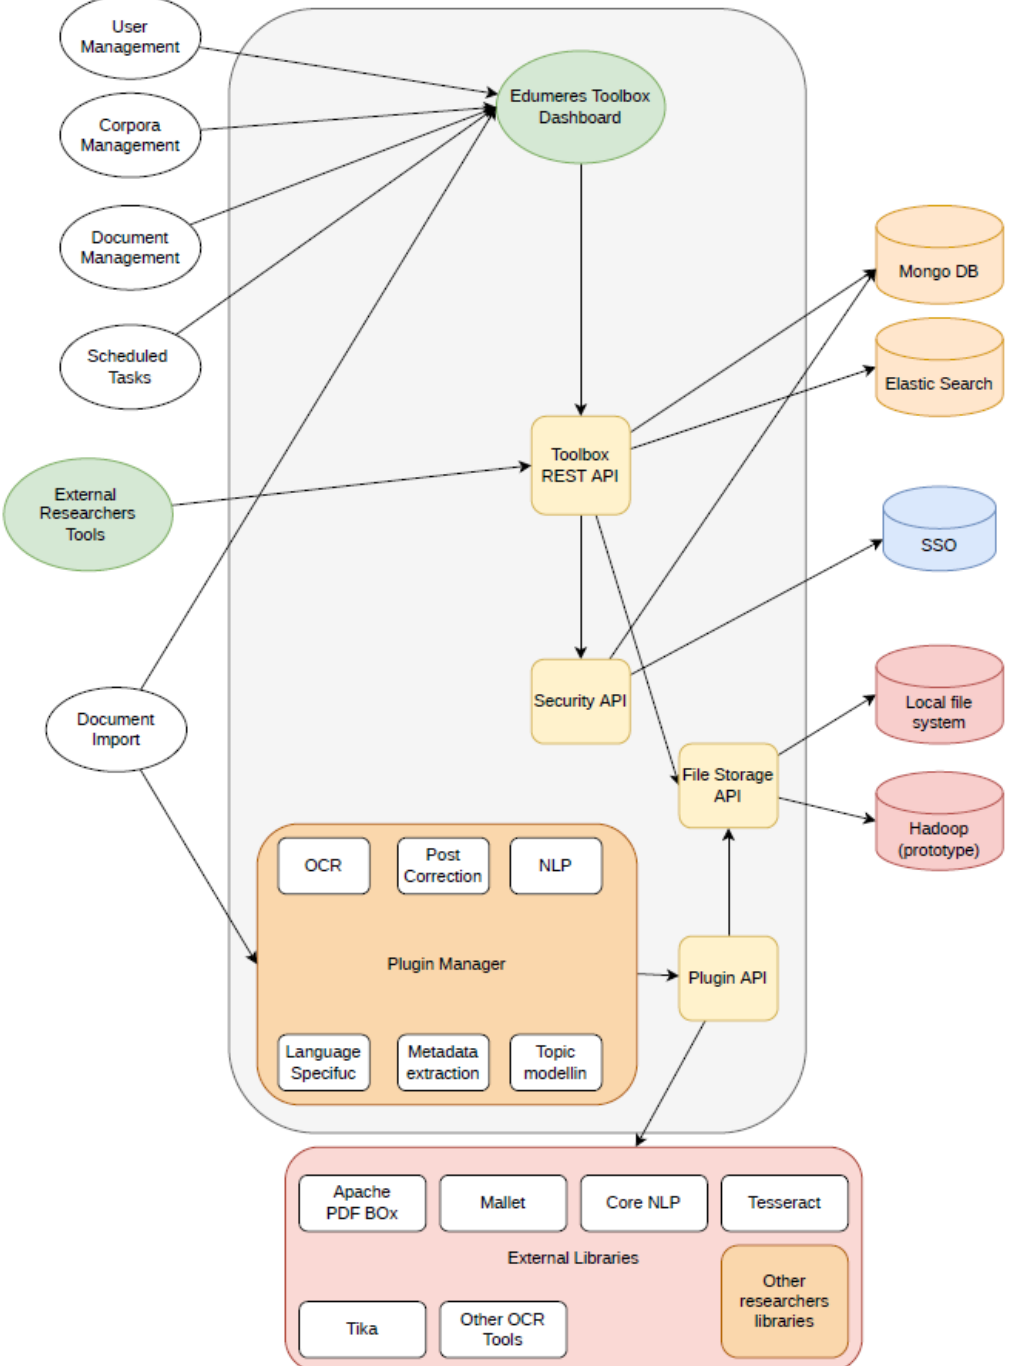
Figure 1. Edumeres Toolbox architecture.